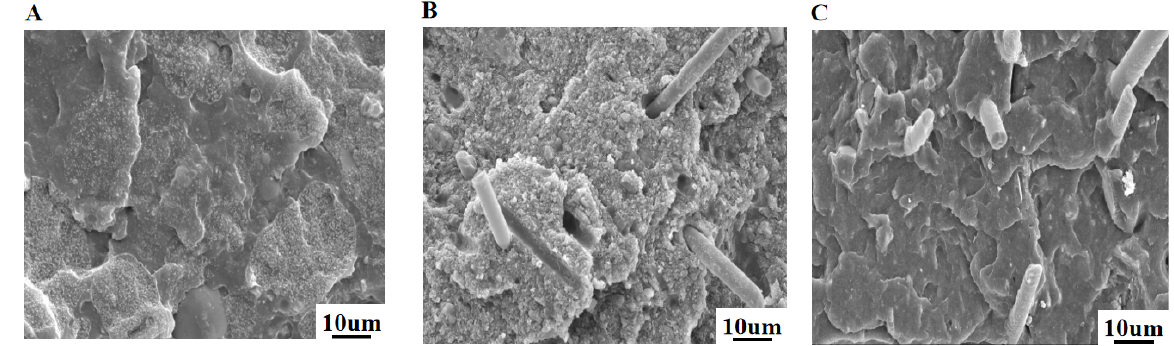
Figure 4: SEM images of (A) DMC/SBR/MVQ (0/0/100), (B) DMC/SBR/MVQ (60/0/100) and (C) DMC/SBR/MVQ (60/25/75).